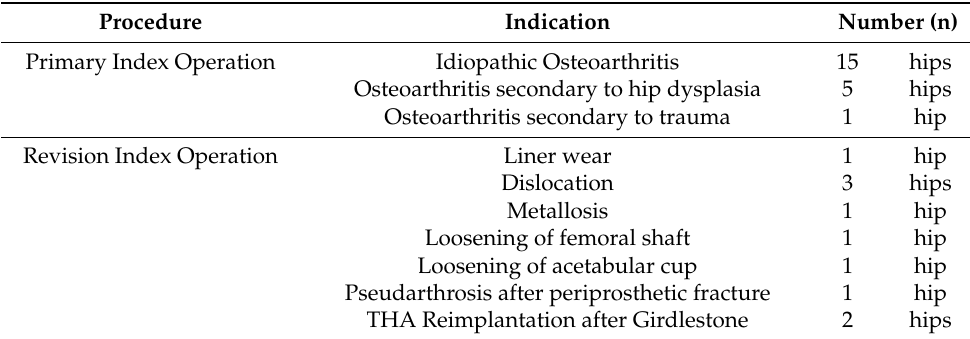
Table 1. Reason for Index